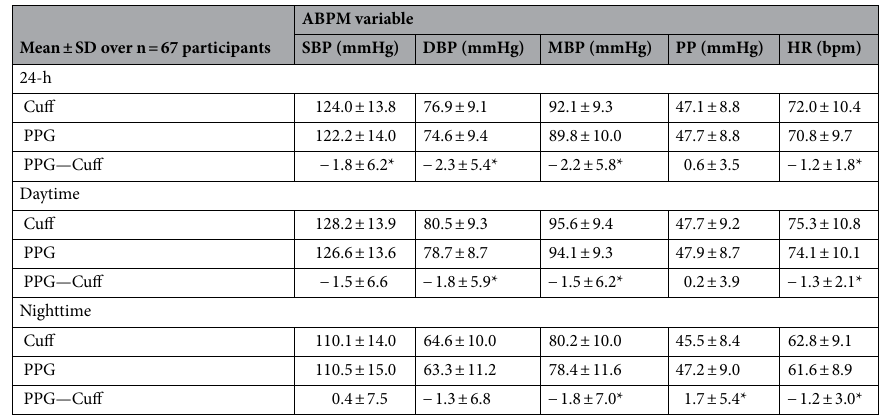
Table 2. Mean and standard deviation (SD) of the average 24-h, daytime and nighttime cuff-derived ABPM variables and their PPG-derived counterparts. ABPM ambulatory blood pressure monitoring, PPG